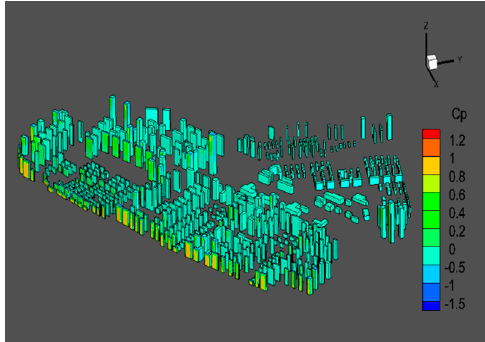
Figure 10. Coefficients of wind pressure.